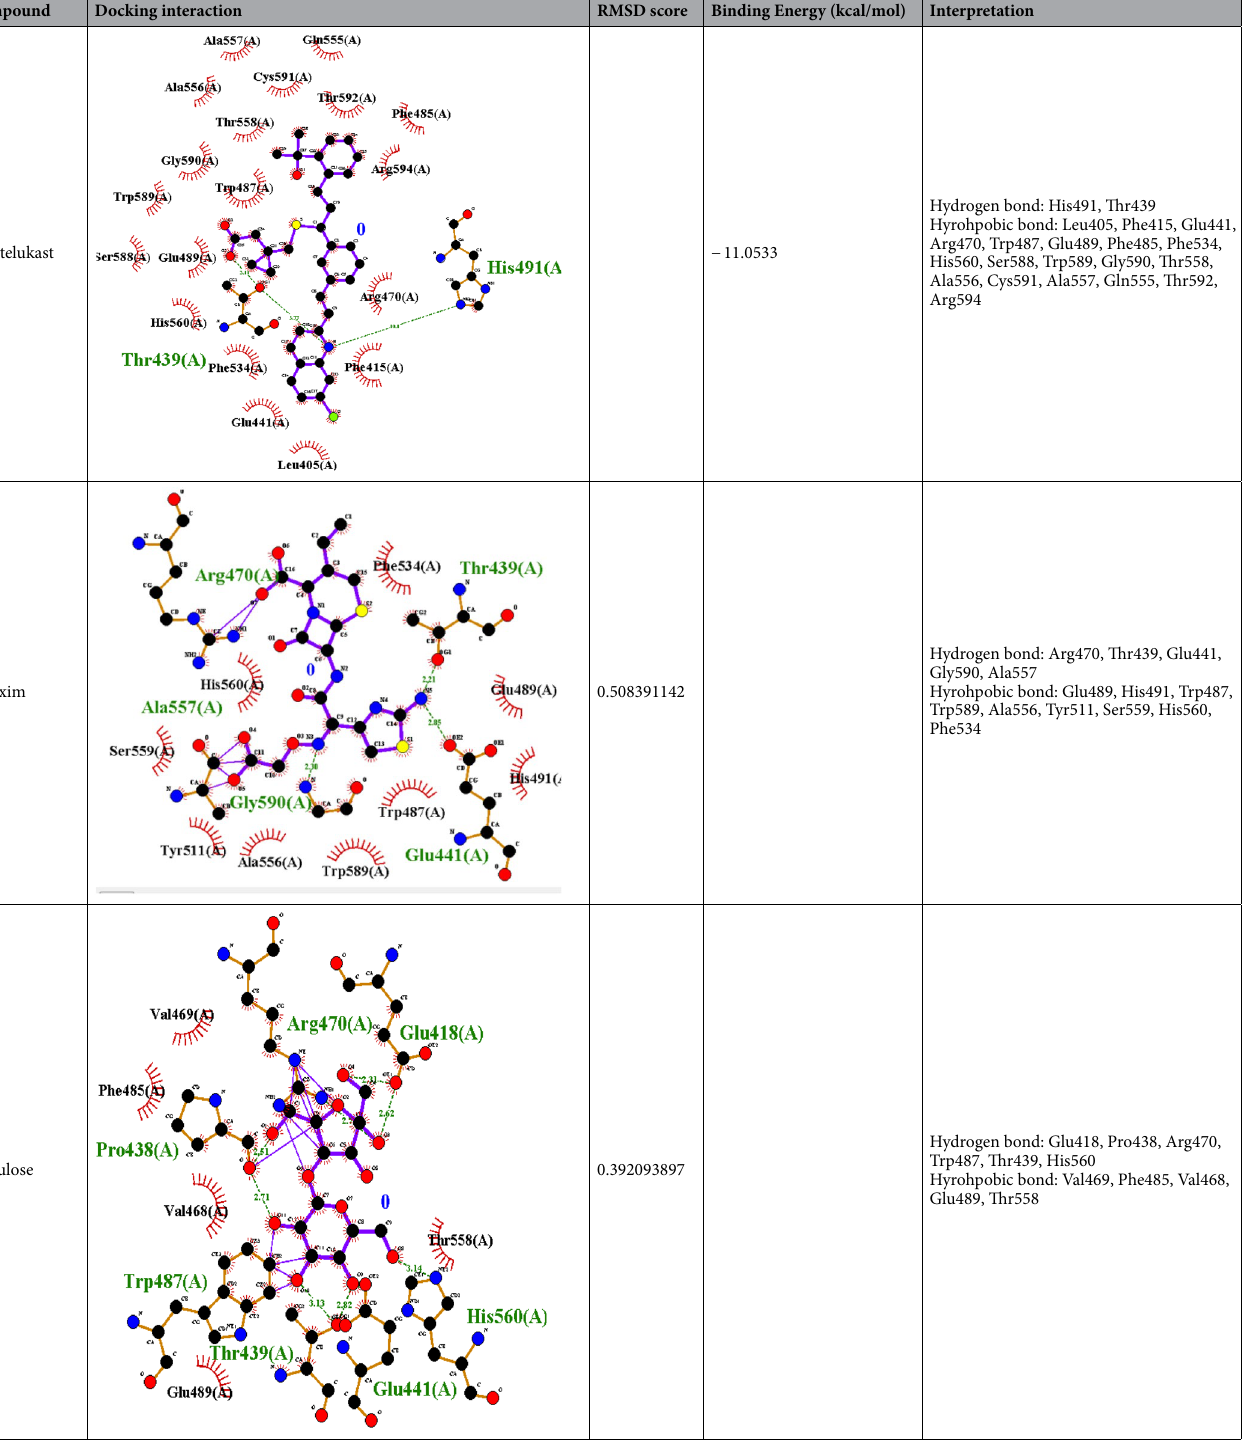
Table 2. Summary of the best docking interactions (Binding Energy: ˂ − 10.0 kcal/mol) of the FDA-approved drugs against the TgPRS protein. Interactions were analyzed and visualized using LigPlot +